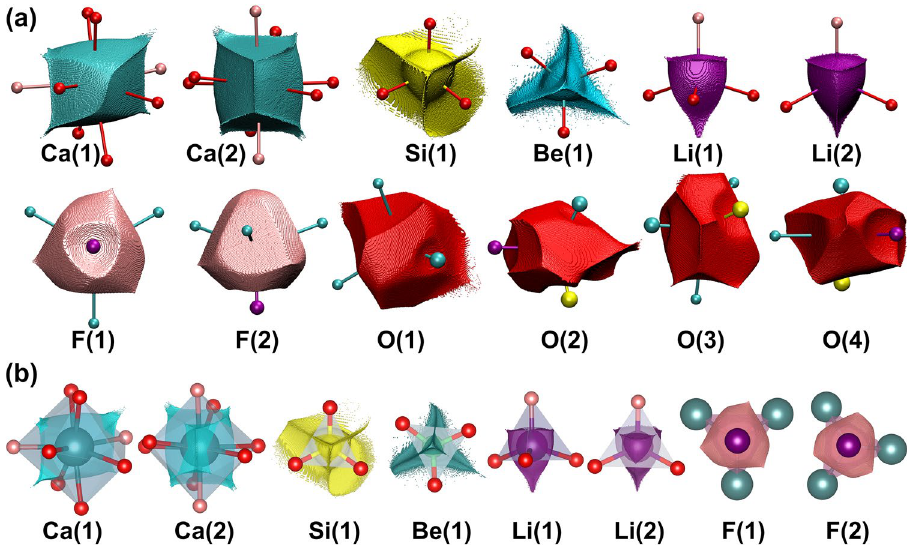
Figure 2. Atomic basins of particular ions present in the His structure at 1.9 GPa ( a ) and an overlay of the particular coordination polyhedra and corresponding atomic basins ( b ).